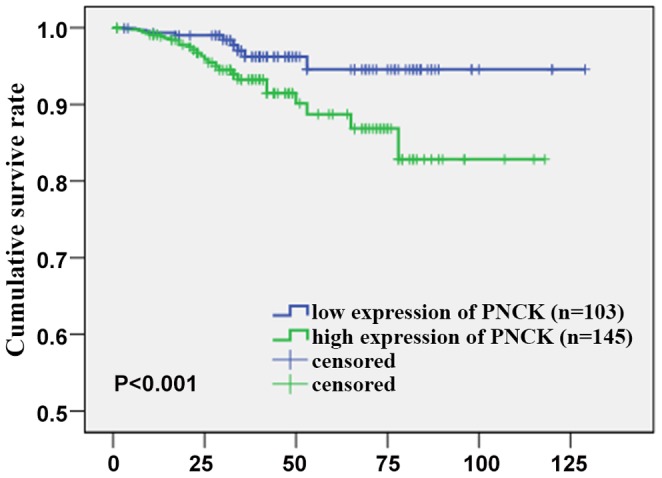
Overall survival. Kaplan-Meier survival analysis of primary ccRCC patients (n = 248) after surgical resection with low PNCK expression (n = 103) and high PNCK expression (n = 145).The survival rate for patients in the PNCK high group was significantly lower than that for patients in the PNCK low group (log-rank test, p<0.001).